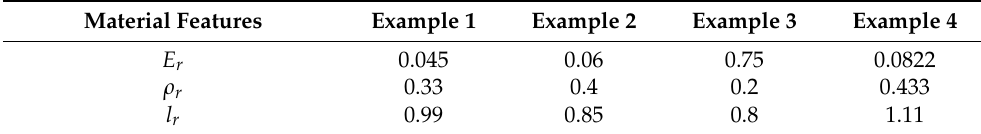
Table 3. Random designs of material properties for the micro-PnC